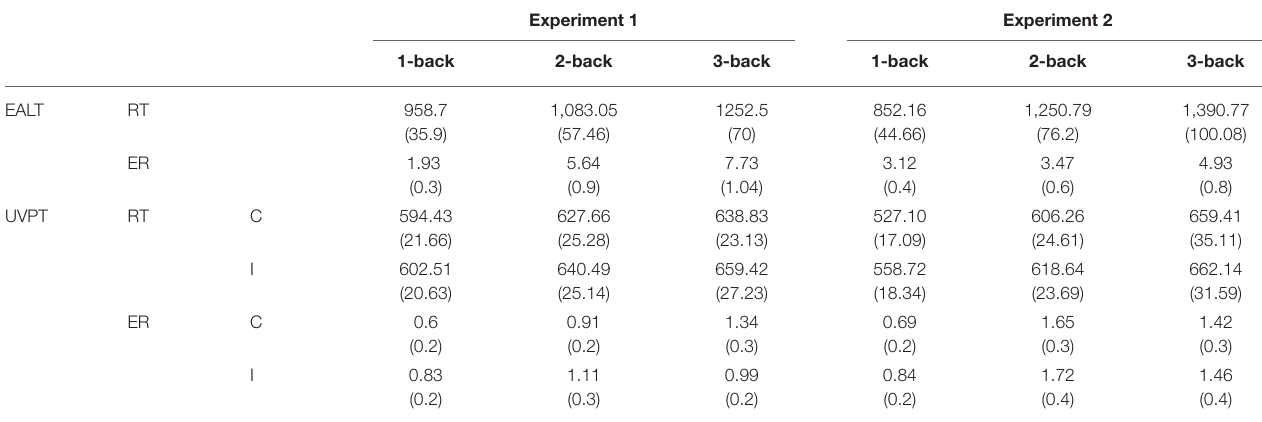
TABLE 1 | Mean reaction times (RTs in milliseconds), and error rates (ERs in percentage) as a function of executive attention load (1-back vs.2-back vs.3-back), and congruency conditions (congruent vs. incongruent) in Experiments 1 and